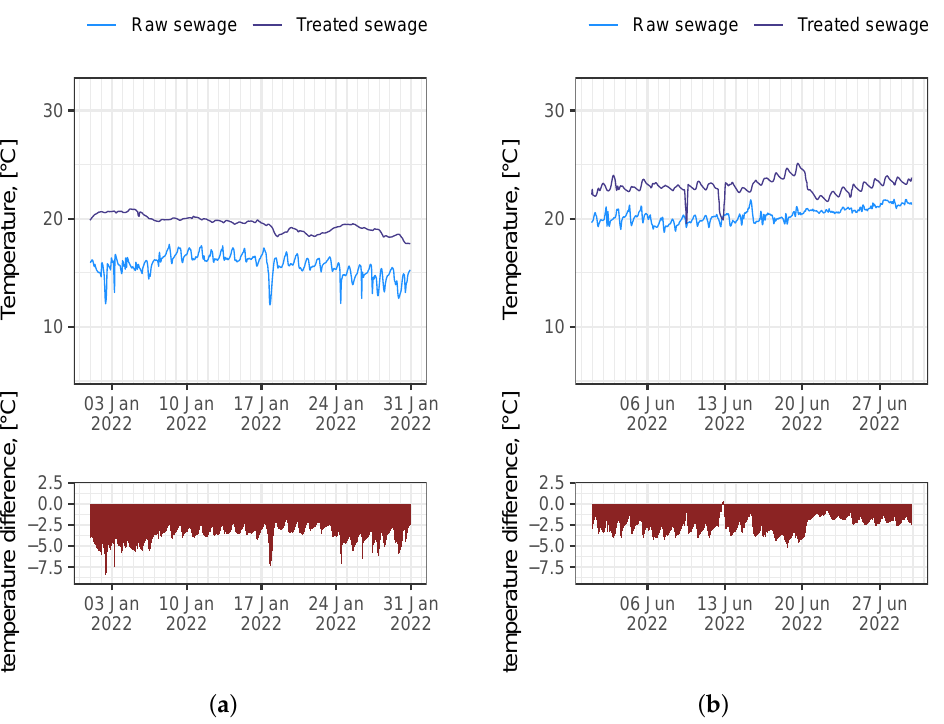
Figure 8. Course and temperature difference of raw and treated sewage. ( a ) January 2022; ( b ) June 2022.